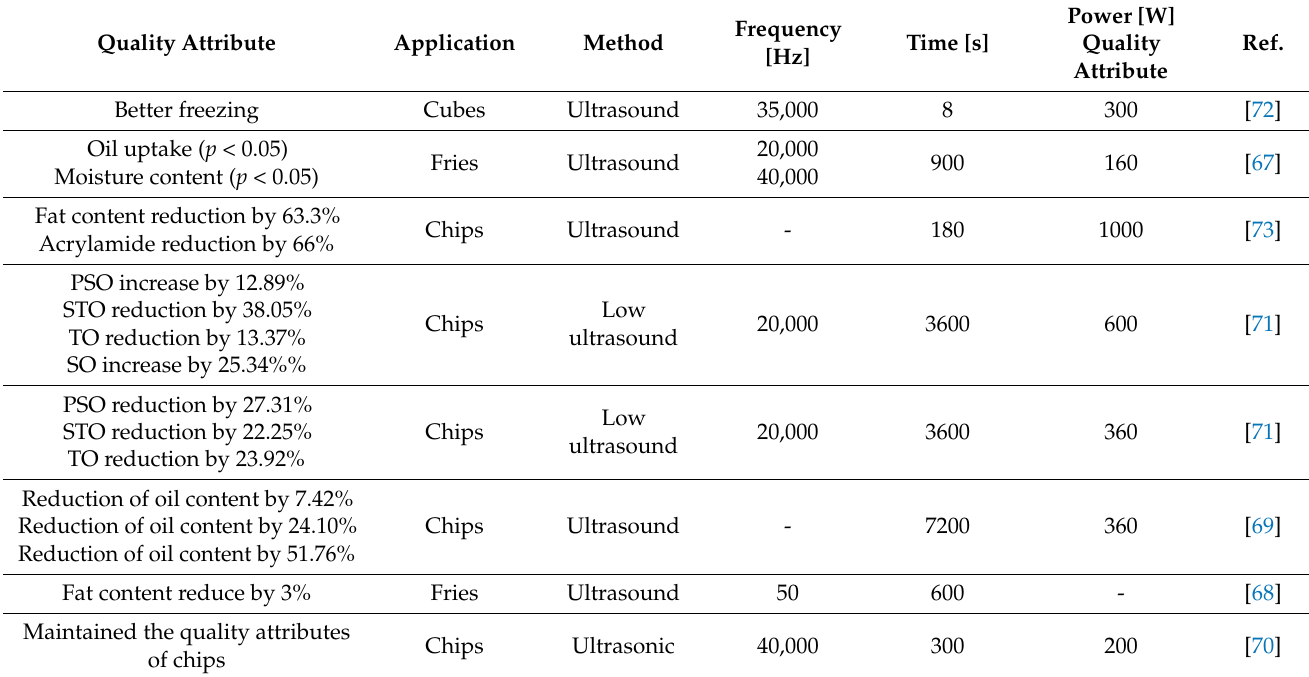
Table 2. Application of ultrasonic methods in quality assessment of processed